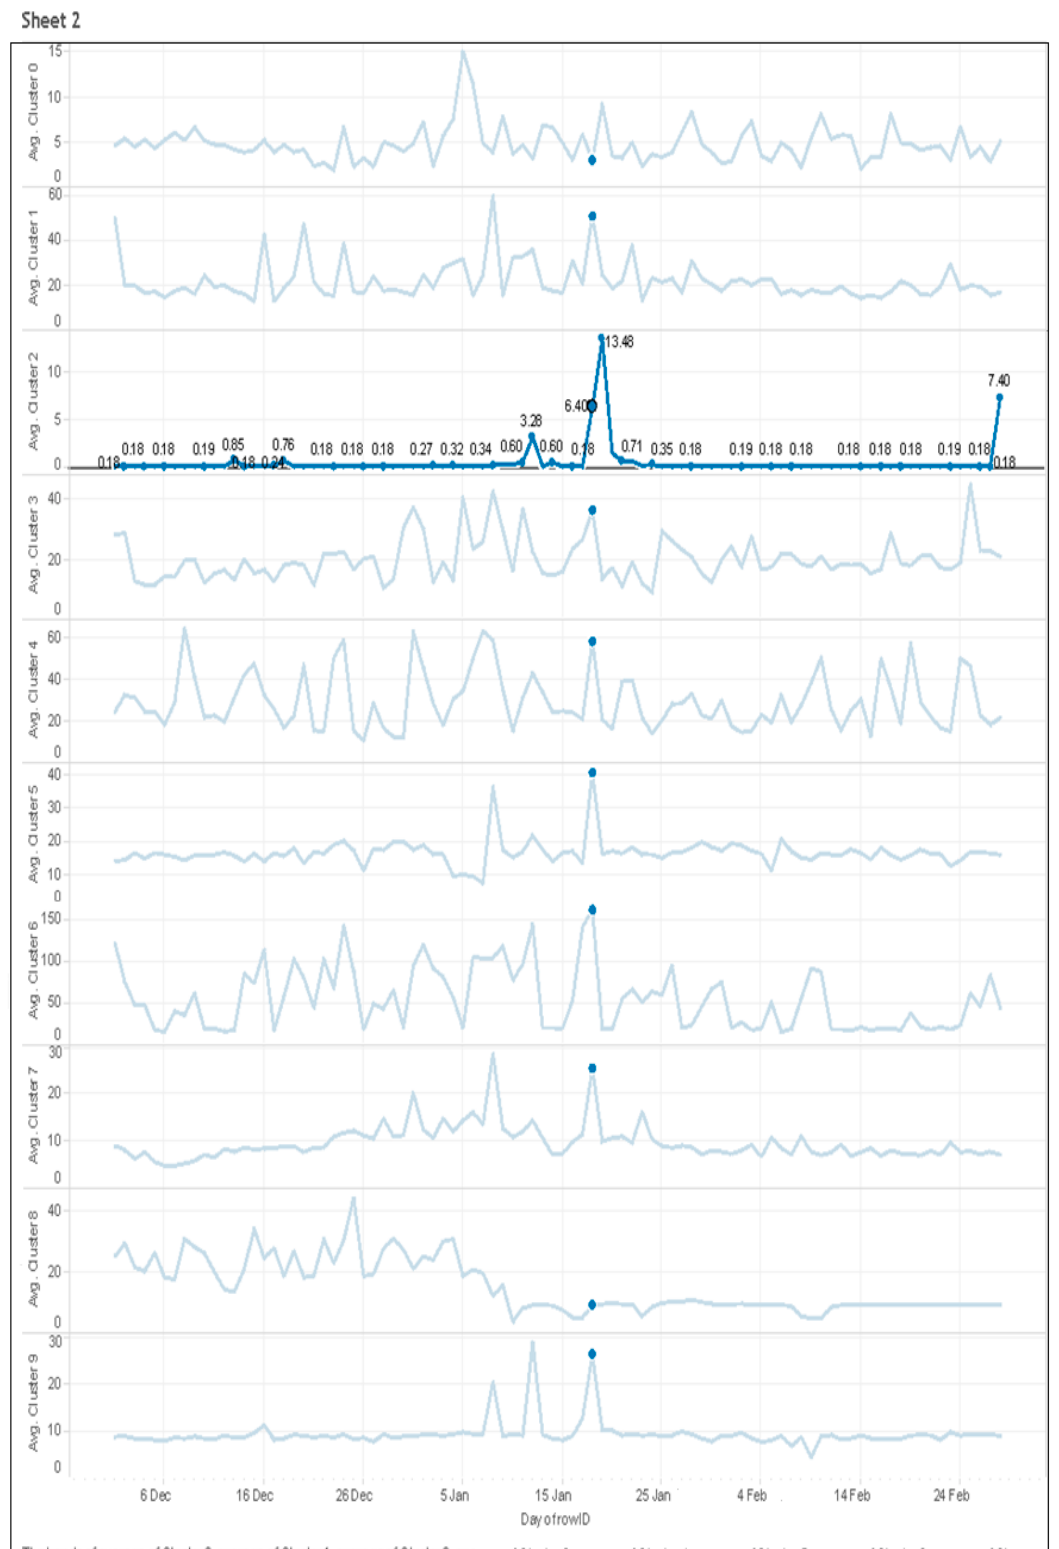
Figure 9. Average daily usage of clusters.